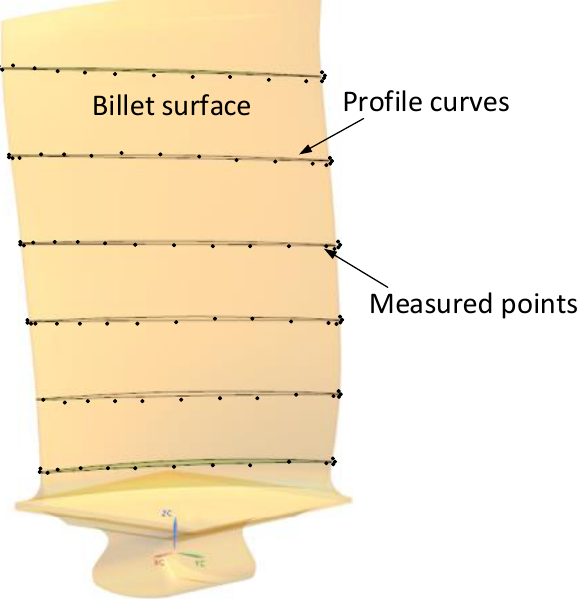
Figure 2. The billet surface is represented by the measured points. The blade surface is usually divided into the suction-surface segment, the pressure- surface segment, the leading-edge segment, and the trailing-edge segment. Different tolerances are required for these surface areas. After the blade surface localization, the profile of the to-be-cut blade surface segment needs to be within the respective profile tolerance zone (Figure 3).